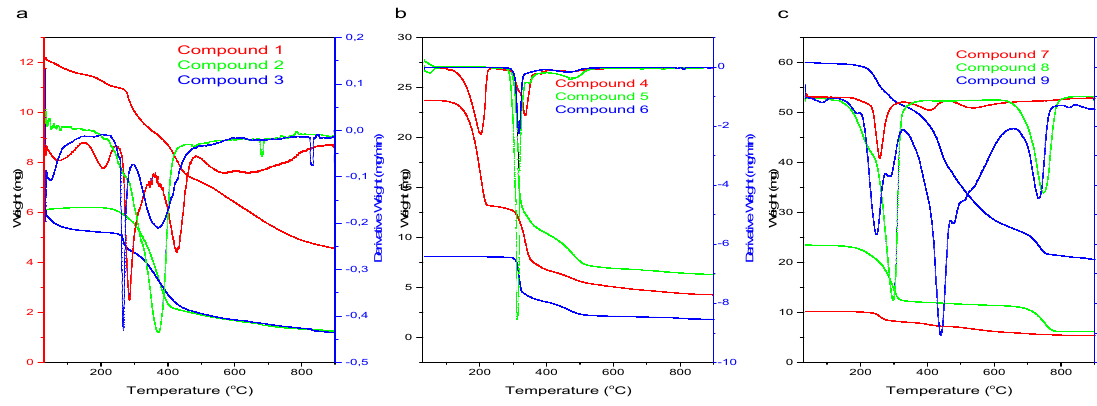
Figure 2. ( a – c ) Thermogravimetric and derivative thermal analysis plots of Schiff bases 1 – 9 .